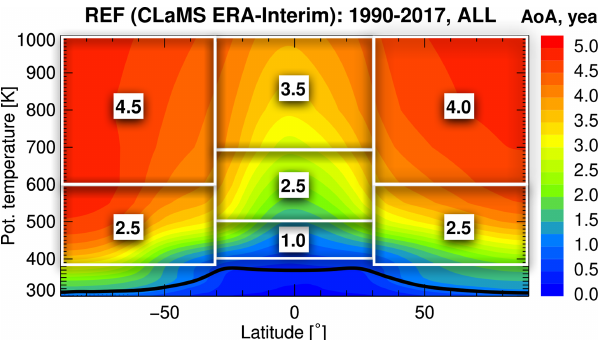
Figure B1. AoA zonal mean. Zonal mean of AoA from CLaMS simulation driven by ERA-Interim reanalysis. Data shown are the climatology for 1990–2017. Regions defined with the white boxes are used for the idealized age spectrum calculations in the improved approximation method. Values denoted in each box are an approxi- mate averaged AoA value of the region bounded by white